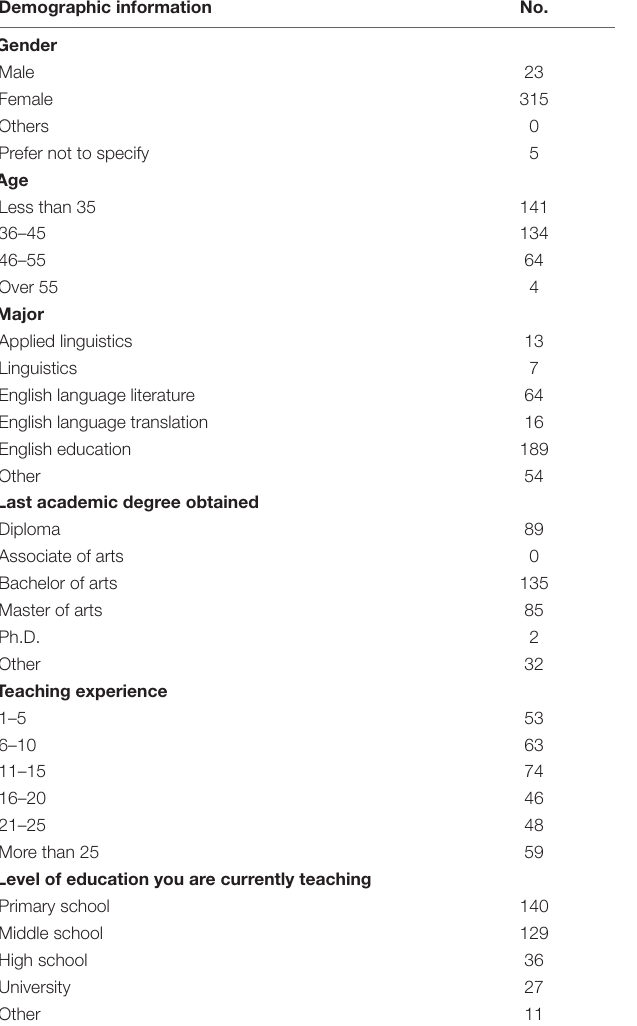
TABLE 1 | Participants’ demographic information. TABLE 2 | Unstandardized and standardize estimates of the initial CFA